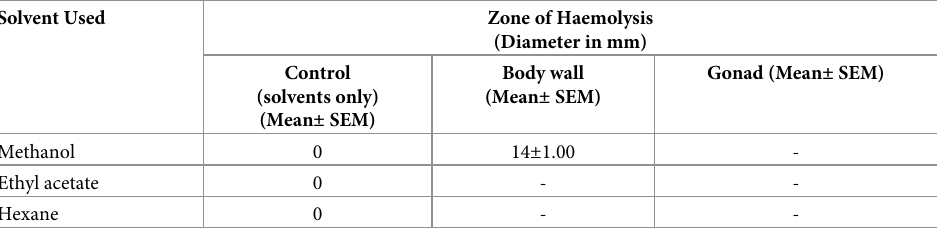
Results are illustrated as the mean diameter of haemolysis zones (mm) ± standard error of the means (n = 3). ‘-’ =